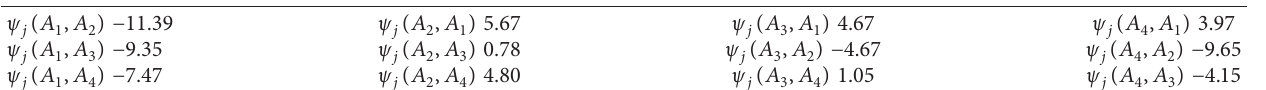
Table 16: The dominance degrees.